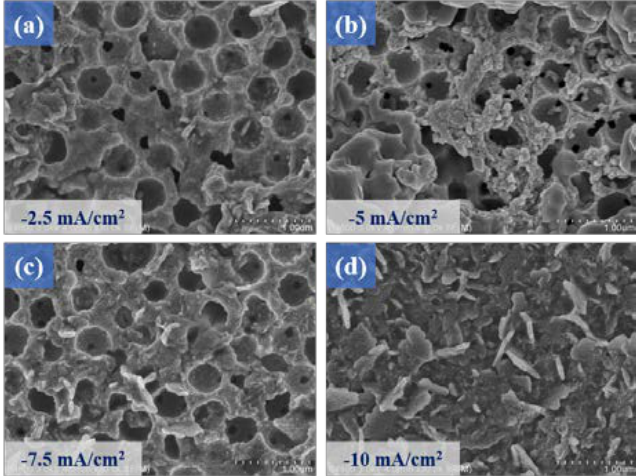
Figure 6. Top-view SEM images of the MnS/MoS 2 /Ni-IOS microelectrode samples fabricated with different electrodeposition densities, where the 10 min electrodeposition parameters of MnS were selected, and the current densities were ( a ) − 2.5 mA/cm 2 , ( b ) − 5 mA/cm 2 , ( c ) − 7.5 mA/cm 2 , and ( d ) − 10 mA/cm 2 .